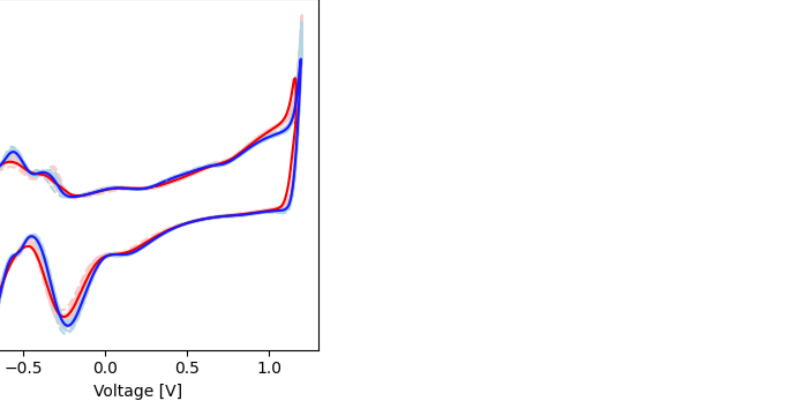
Figure 4. CV plots before and after short-term electrochemical testing. The dashed red and blue lines represent measurements made before and after electrical stimulation, respectively. The solid red and blue lines are the averages of the values before and after electrical stimulation, respectively. Table 2. CV faradaic peaks and associated electrochemical reactions before and after short-term electrochemical testing.